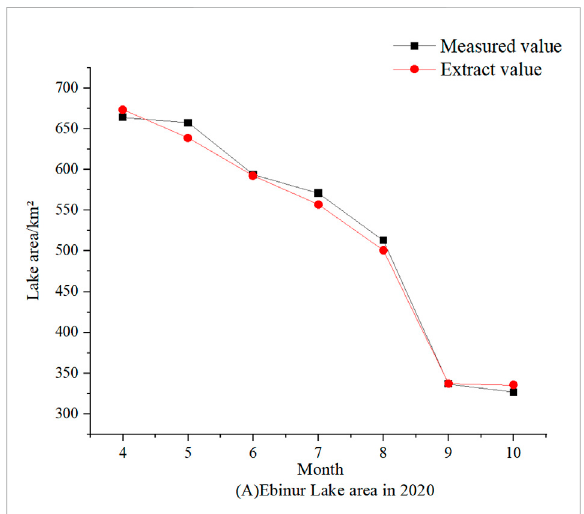
FIGURE 2 Results of change and comparison of Ebinur Lake surface area in 2020, from measured and extracted data. (A) Ebinur Lake area in 2020 (B) Area comparison (in the Supplementary